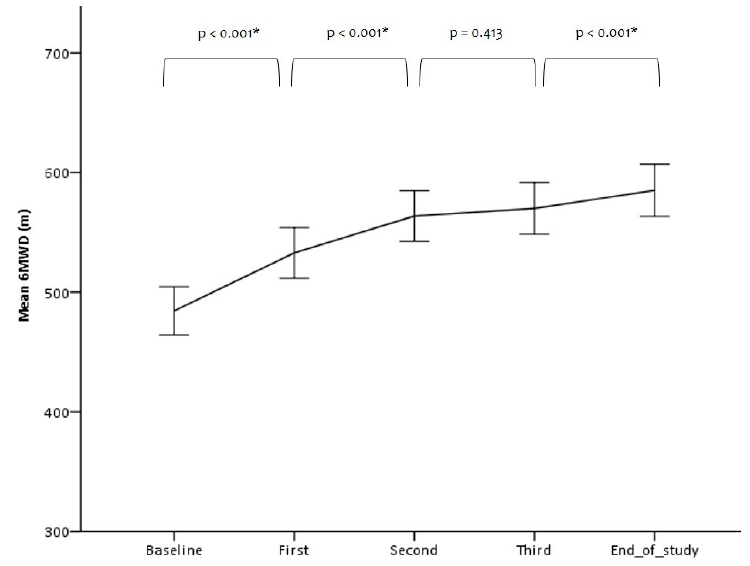
Figure 1. Means and standard deviations of six-minute walking distance (6MWD) for each measurement session throughout the rehabilitation program. * p < 0.05.